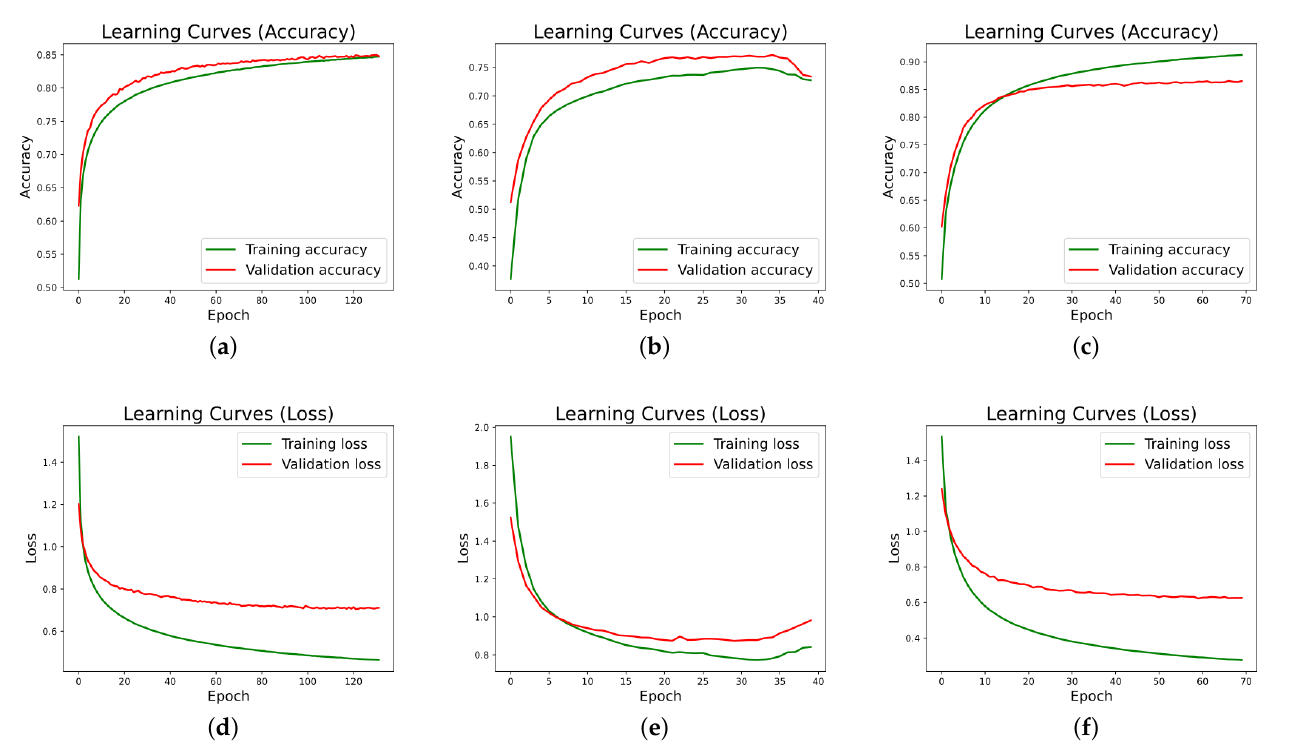
Figure 10. Neural network training graphs for user 2. ( a ) Model RNN Accuracy User 2, ( b ) Model LSTM Accuracy User 2, ( c ) Model GRU Accuracy User 2, ( d ) Model RNN Loss User 2, ( e ) Model LSTM Loss User 2, ( f ) Model GRU Loss User 2.